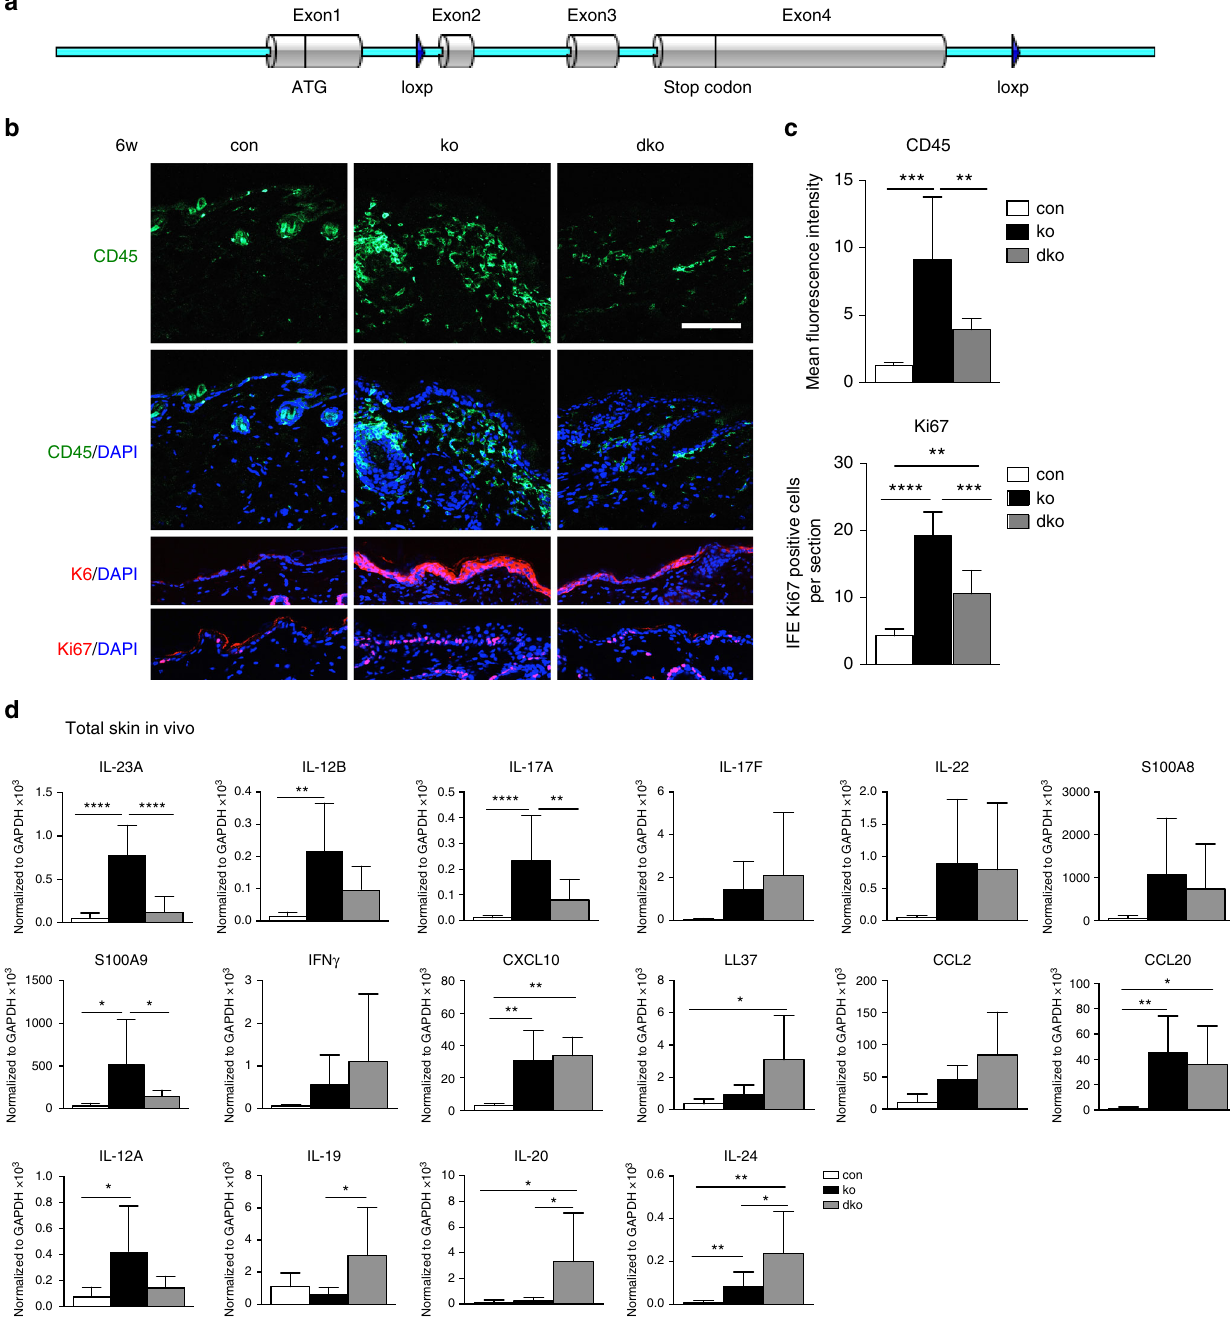
Fig. 5 Keratinocyte-derived IL-23p19 is important for skin in fl ammation in N-WASP knockout. a Strategy of loxP insertion in mouse IL-23A gene. b , c CD45, K6, Ki67 immuno fl uorescence of back skin section from 6-week-old con, ko, and dko ( b ), quanti fi cation of mean fl uorescence intensity of CD45, and quanti fi cation of Ki67-positive cells in interfollicular epidermis (IFE) ( n : 5/5/5, mean ± SD, one-way ANOVA, with Tukey ’ s multiple comparisons). Scale bar: 100 µ m. d qRT-PCR analysis of indicated genes from back skin RNA 6 – 8-week-old of con, ko, and dko mice. All normalized to GAPDH ( n > = 6/6/6, mean ± SD, one-way ANOVA, with Tukey ’ s multiple comparisons; * p ≤ 0.05; ** p ≤ 0.01; *** p ≤ 0.001; **** p ≤